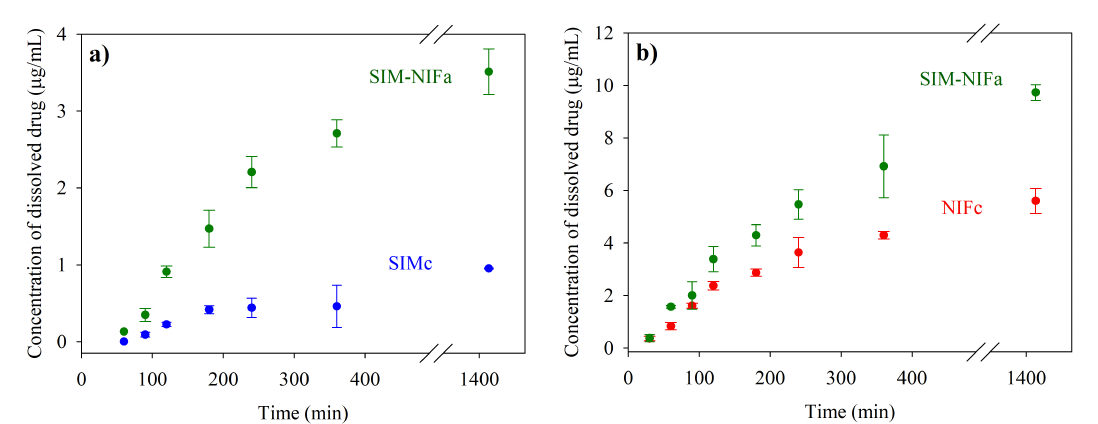
Figure 5. Aqueous dissolution profiles for pure crystalline APIs (SIMc and NIFc) and co-amorphous